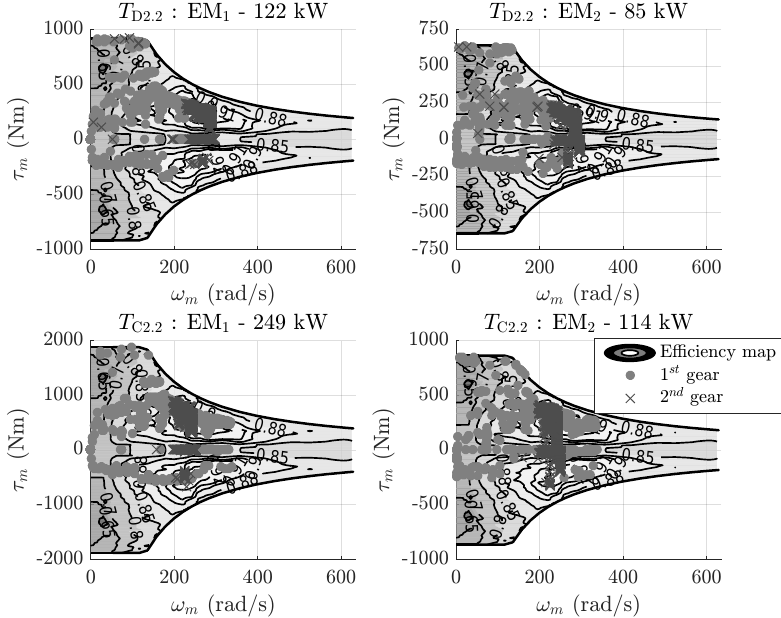
Figure 13. Visualization of the workpoints of the electric machines over the drive cycle for both T D 2.2 and T C 2.2 . The workpoints correspond with the workpoints shown in Figure 12, however, here plotted for each electric machine in the powertrain. The upper plots indicate the use of the electric machines, where (EM 1 only) means that only EM 1 supplies power to the wheels, and (EM 2 only) that this is only done by EM 2 . (Dual motor) indicates that both machines together drive the wheels of the vehicle. The lower two plots indicate the engaged gear for each